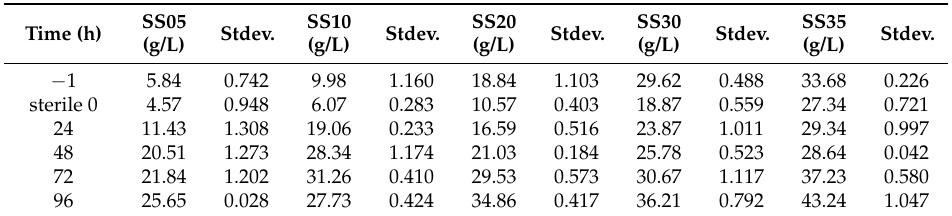
Table 3. Suspended solids (SS) concentration for fermentations performed with different sludge solid